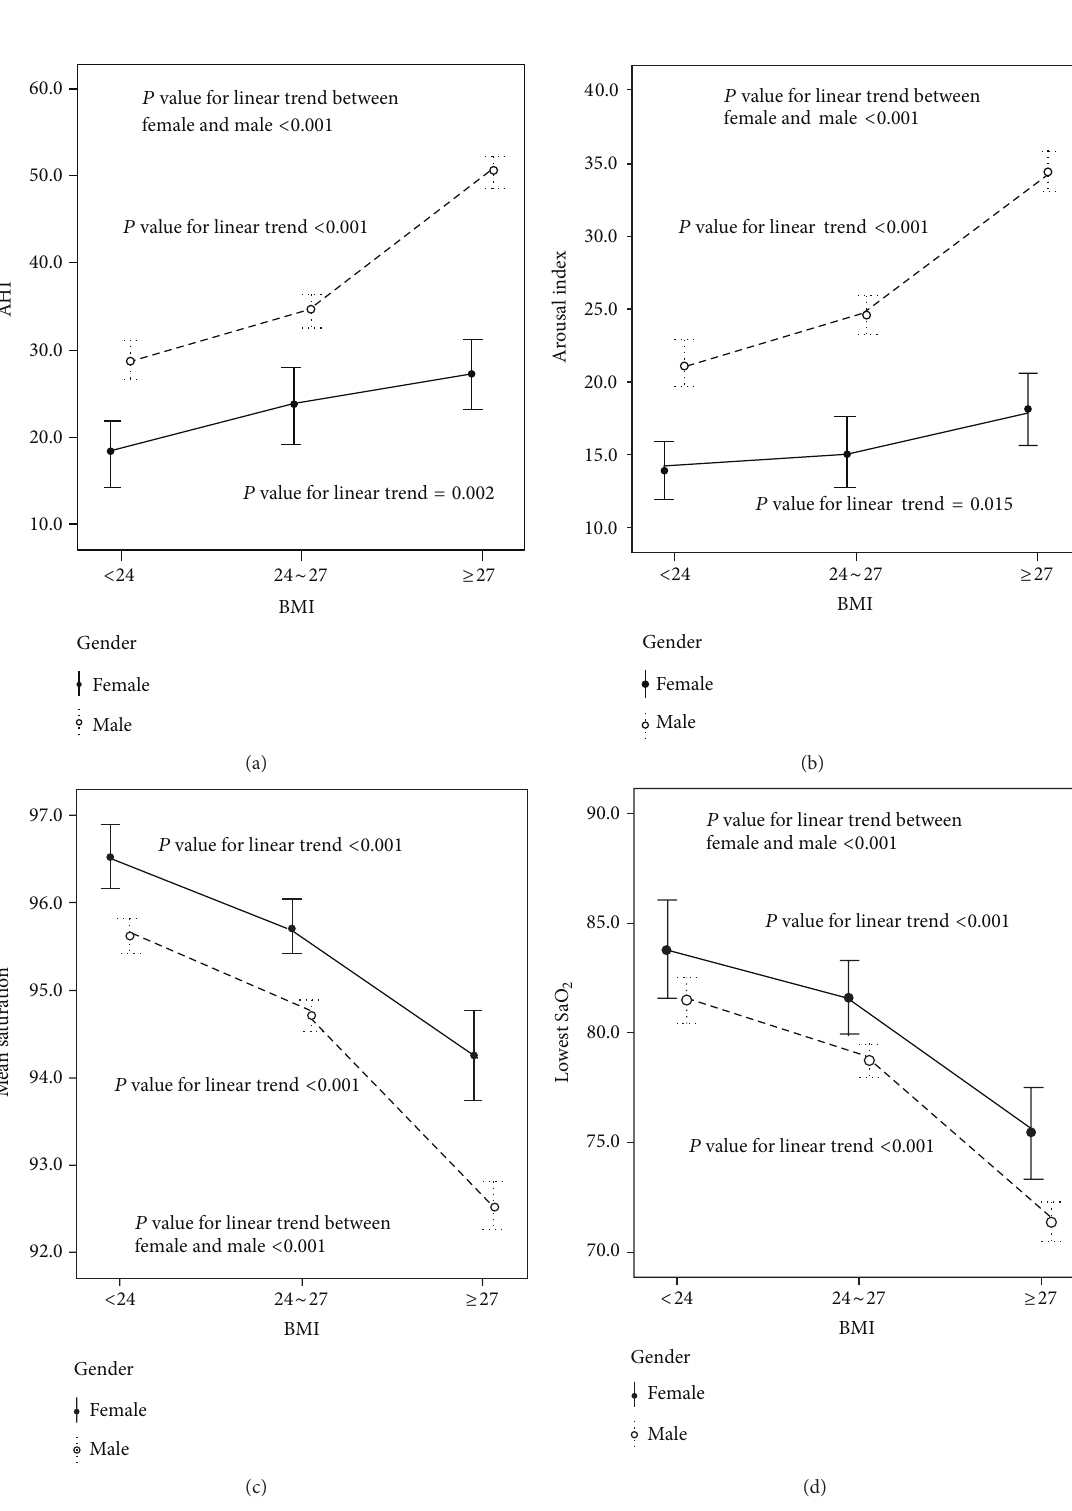
Figure 1: The trends of AHI, arousal index, mean saturation, and lowest saturation in both male and female patients with obstructive sleep apnea (OSA). As the BMI increased, the AHI and arousal index increased significantly, while the mean saturation and lowest saturation decreased significantly in both genders. These trends were significantly predominant in the male